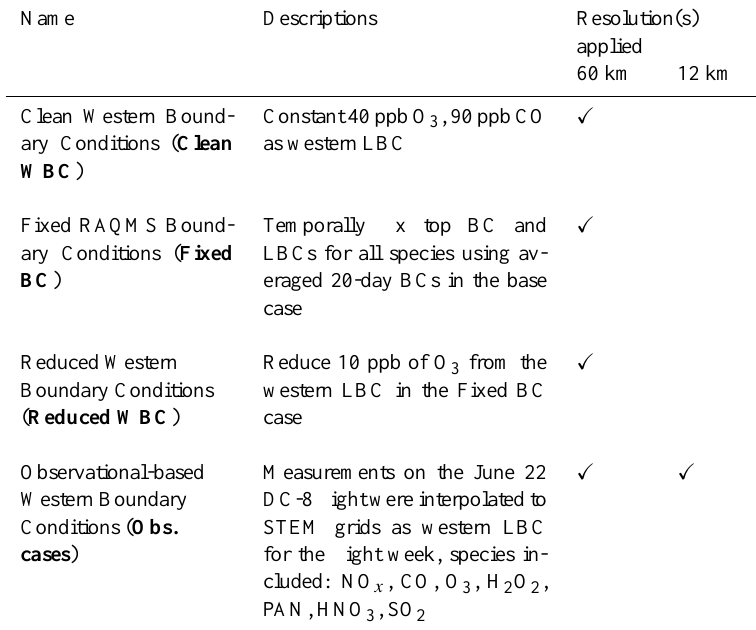
Table 2. Summary of STEM lateral boundary condition sensitivity